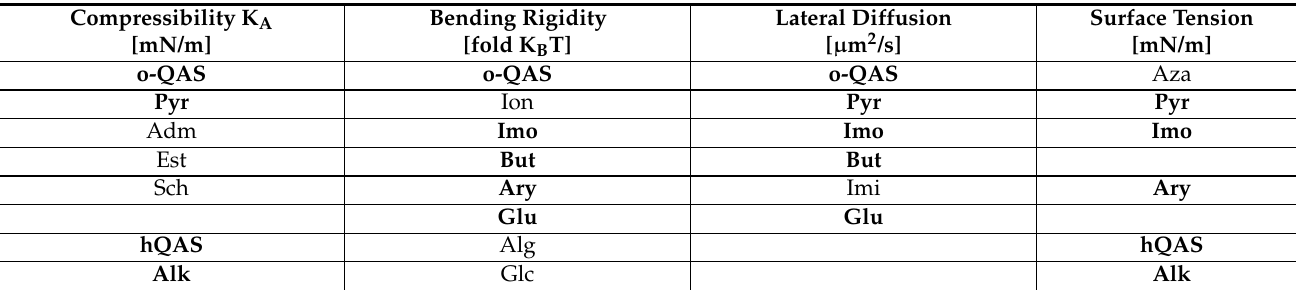
Figure 6. Surface tension, which was determined for membrane systems after the incorporation of investigated Gemini molecules. Table 2. Selected potential antimicrobial candidates from each parameter group. It is suggested to compare those in experimental studies. Frequently appearing molecules were bolded to emphasise their repetition between different parameters consideration.